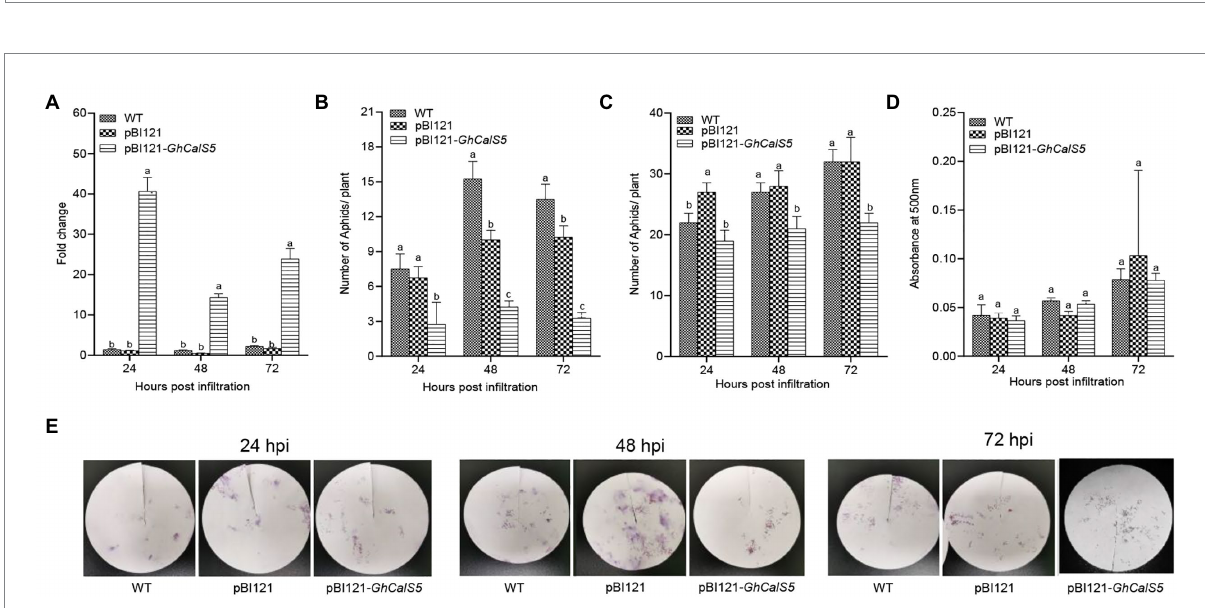
FIGURE 3 Overexpression GhCalS5 inhibited the population of cotton aphids in cotton plants. (A) transient expression of GhCalS5 in cotton leaves, (B) choice assay, (C) no-choice assay, (D) absorbance levels of aphid honeydew at 500 nm, (E) aphid honeydew deposition staining by ninhydrin. HPI, hours post infiltration. Number of plants used = 3 per treatment. One-way ANOVA analyzed data. Error bars represents the SD of three biological replicates. Different letters indicate significant differences ( p < 0.05) based on Tukey’s HSD